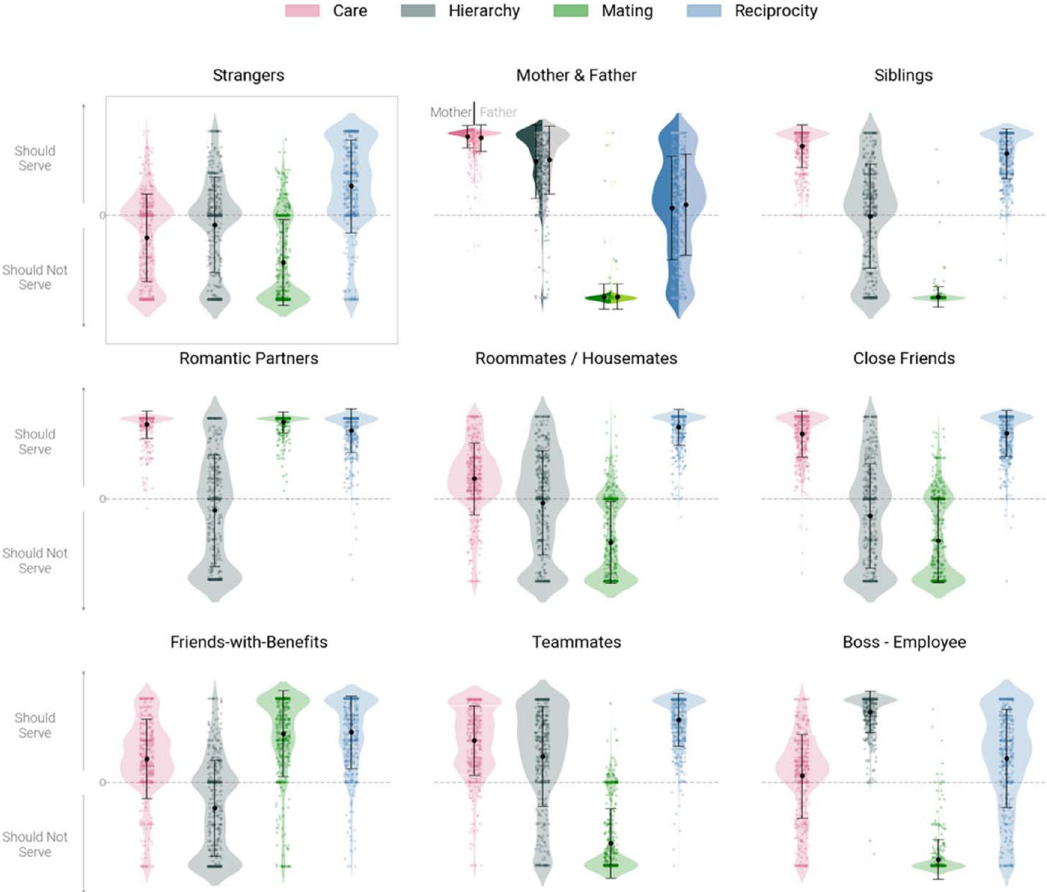
Fig. 2 Relational norm pro fi les for a subset of 10 relationships. Pink represents care, black represents hierarchy, green represents mating, blue represents reciprocity. The raw data ( n = 423 independent ratings per function per relationship; total n = 8,460) are shown in individual dots; error bars represent the mean (dot) and + / − 1 SD (caps). Note: Mother/Father and under-18 child have been combined into a single plot. Plots for all 20 relationships are in Supplement Section 1.4.4. Source data are provided as a Source Data fi